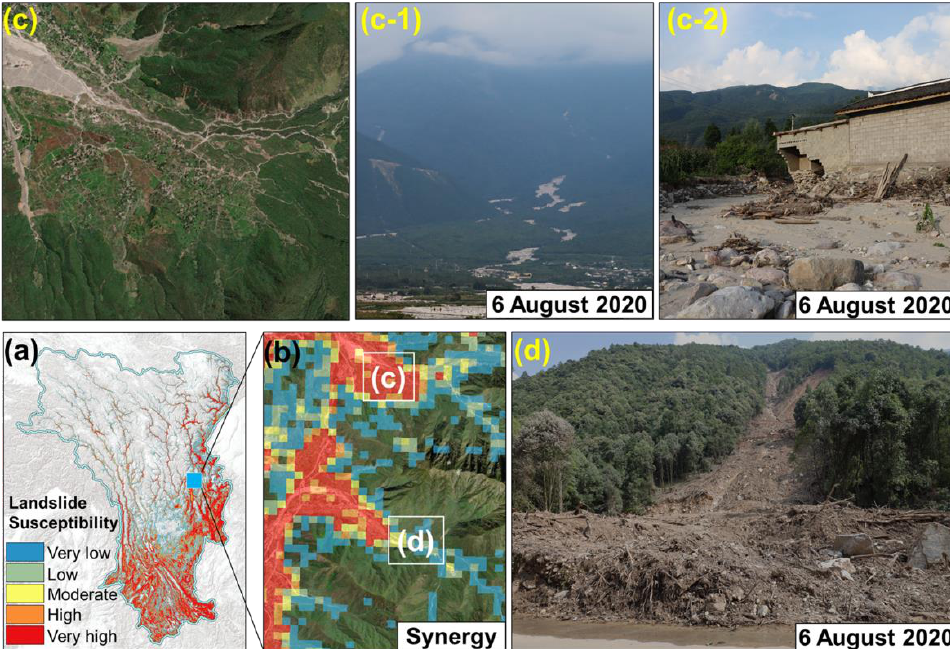
Figure 9. The landslide susceptibility of the central Hengduan Mountains. ( a ) is the LS map of the Hengduan Mountains region; ( b ) shows the landslide assessment result of this area; ( c , d ) are field photos showing the geological disasters that happened at differentsites; ( c-1 ) is a close-up view of c, and ( c-2 ) is a detailed picture of the landslide disaster.